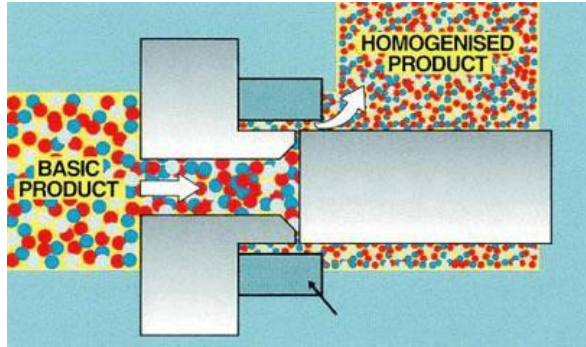
Figure 1: Working principle of high pressure homogenizer